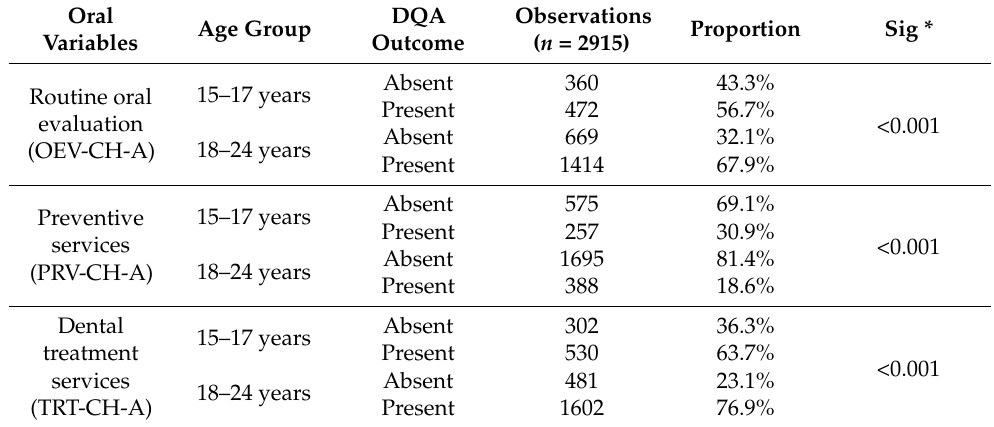
Table 2. Comparison of dental care outcomes between the two age groups.